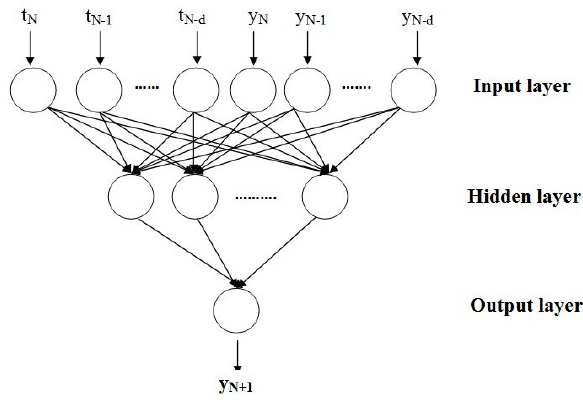
Figure 3. NARX neural network for time series prediction. Figure 2. A Static feed forward neural